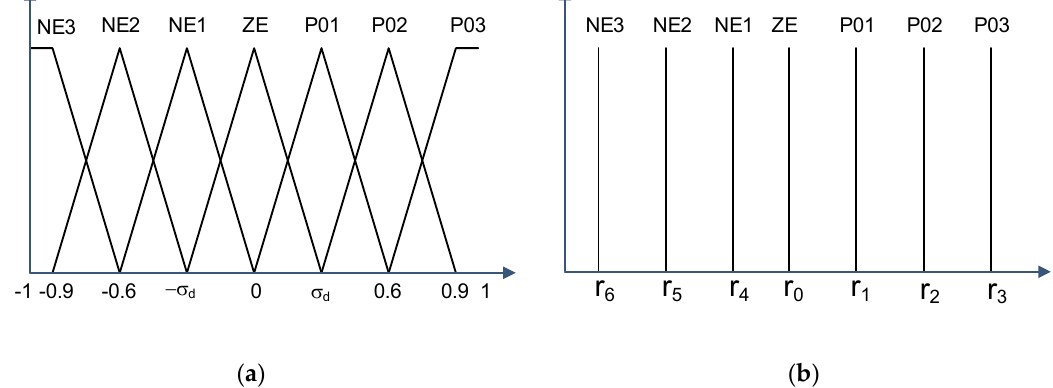
Figure 6. The membership functions for: ( a ) the input variable s and ( b ) the output variable ω hit .